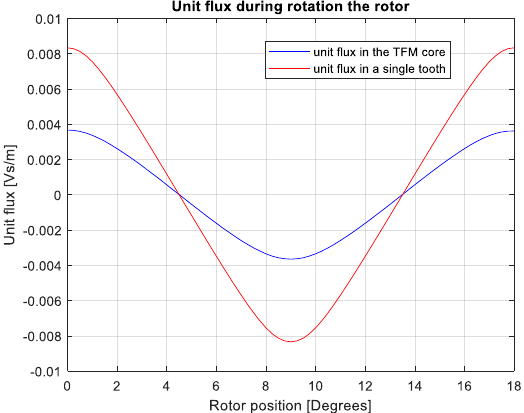
Figure 3. Unit flux changes as the rotor turns 18